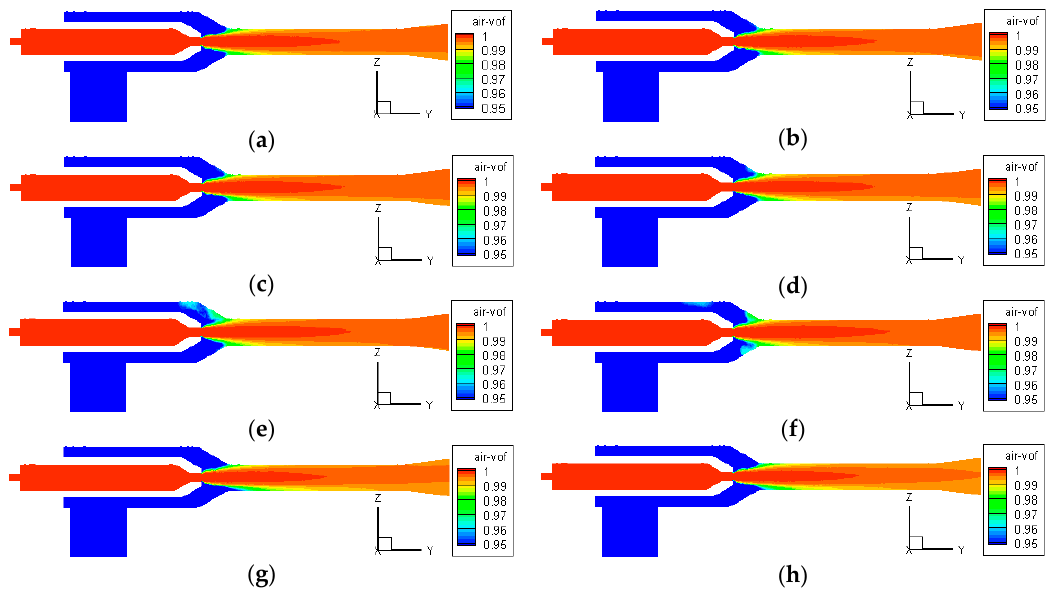
Figure 17. Time-history distribution of air volume fraction: ( a ) t = 3.4 s; ( b ) t = 3.5 s; ( c ) t = 3.6 s; ( d ) t